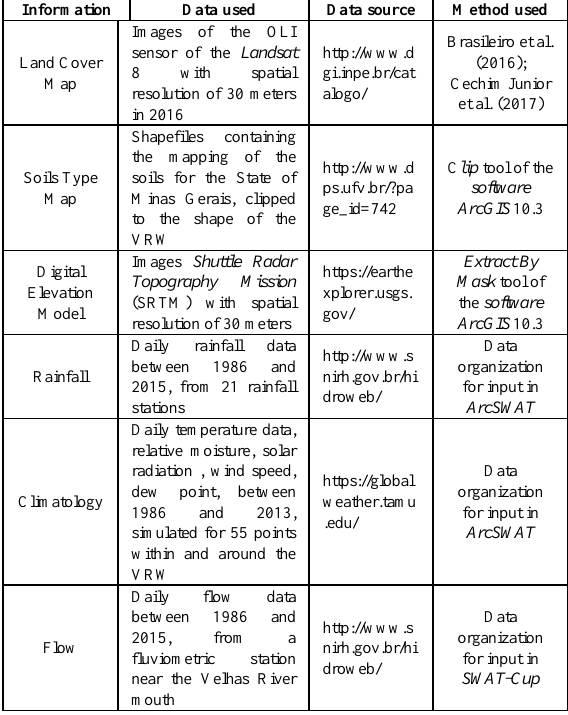
Table 4. Data and methods used to prepare and organize the